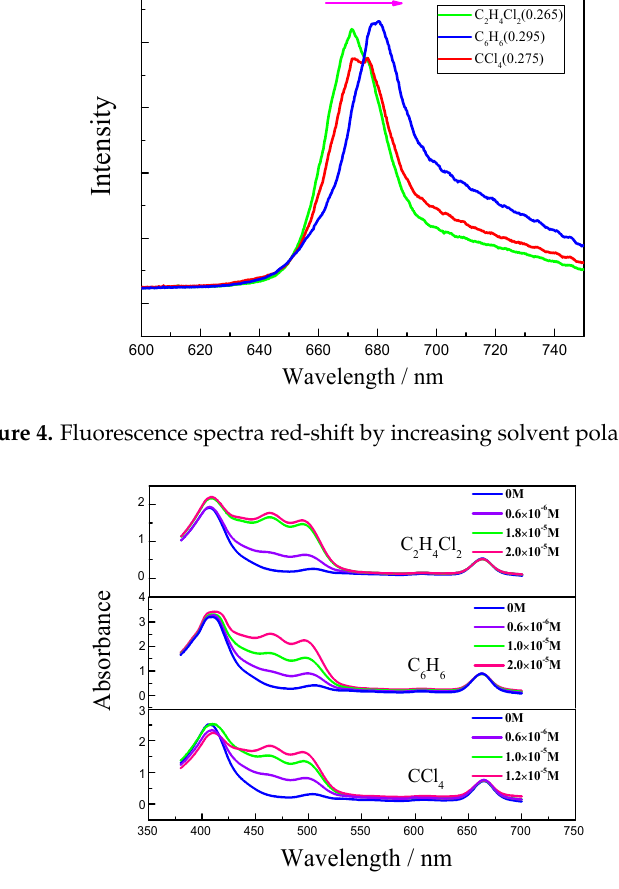
Figure 5. Absorption spectra of Chl-a and β -Car in different polarizability non-polar solvents.